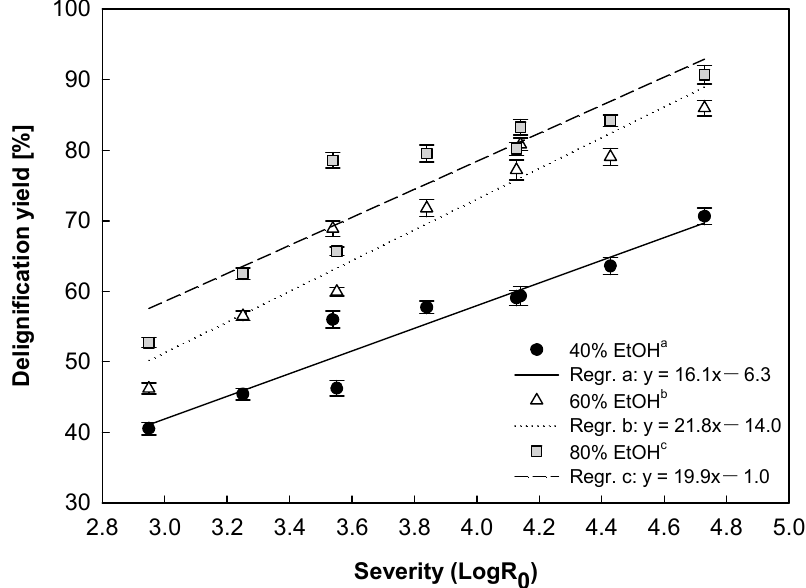
Figure 1. Delignification yield with reaction severity (log R 0 from 2.95 to 4.73) and ethanol concentration. Reaction conditions: 150 °C, 170 °C, and 190 °C for temperature; 30 min, 60 min, and 120 min for time; and 40%, 60%, and 80% for ethanol concentrations; solid:liquid = 1:10; 0.25 wt.% sulfuric acid concentration.